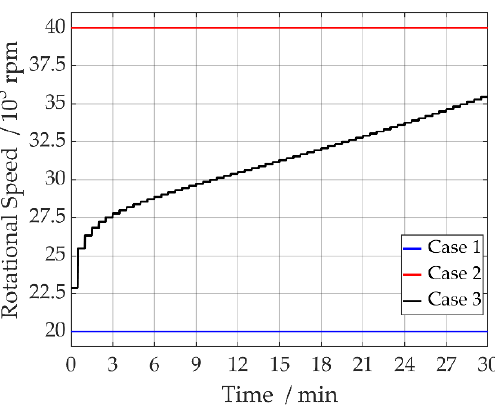
Figure 5. Rotational speed settings for the three cases examined: Blue: Case 1, constantly low; Red: Case 2, constantly high; Black: Case 3, stepwise increase.